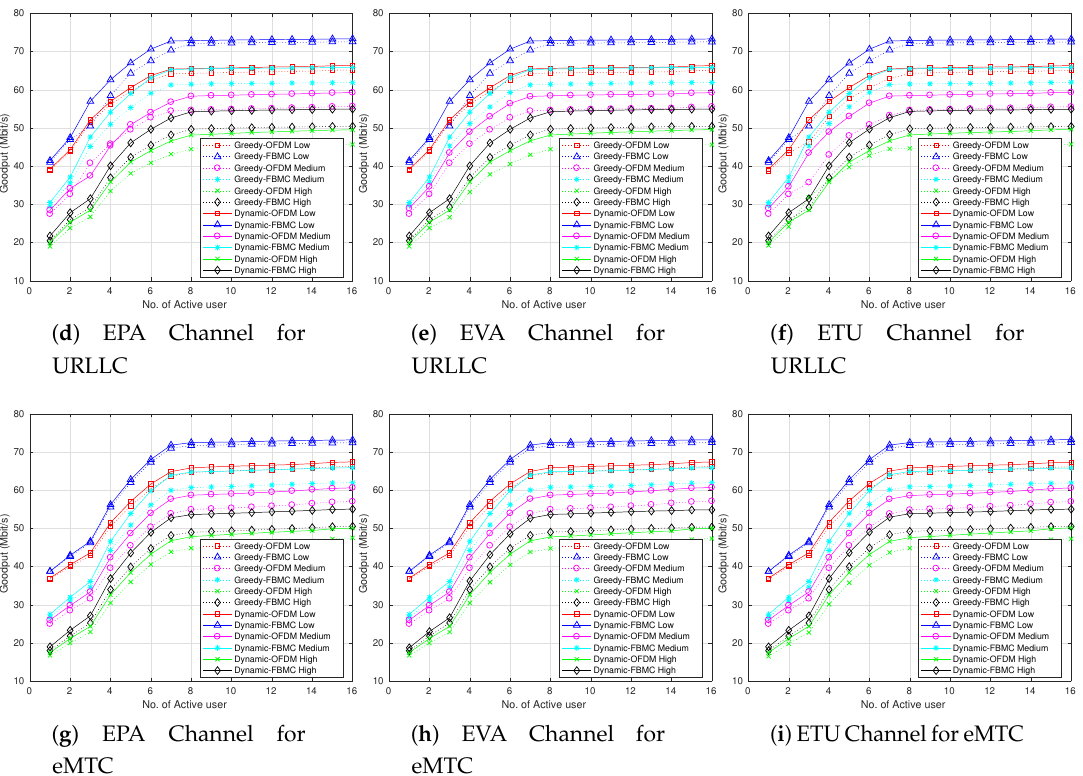
Figure 4. Impact of correlations on average goodput for the greedy and dynamic approaches.